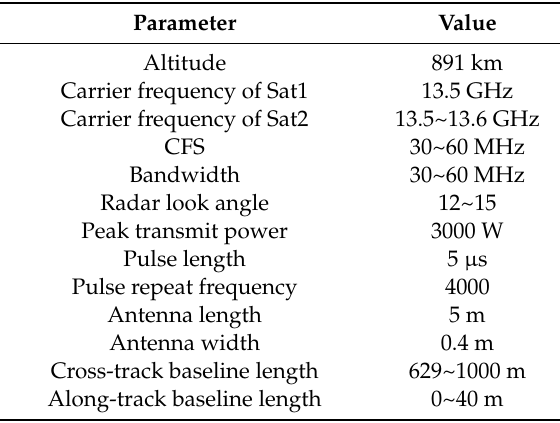
Table 1. System parameters.